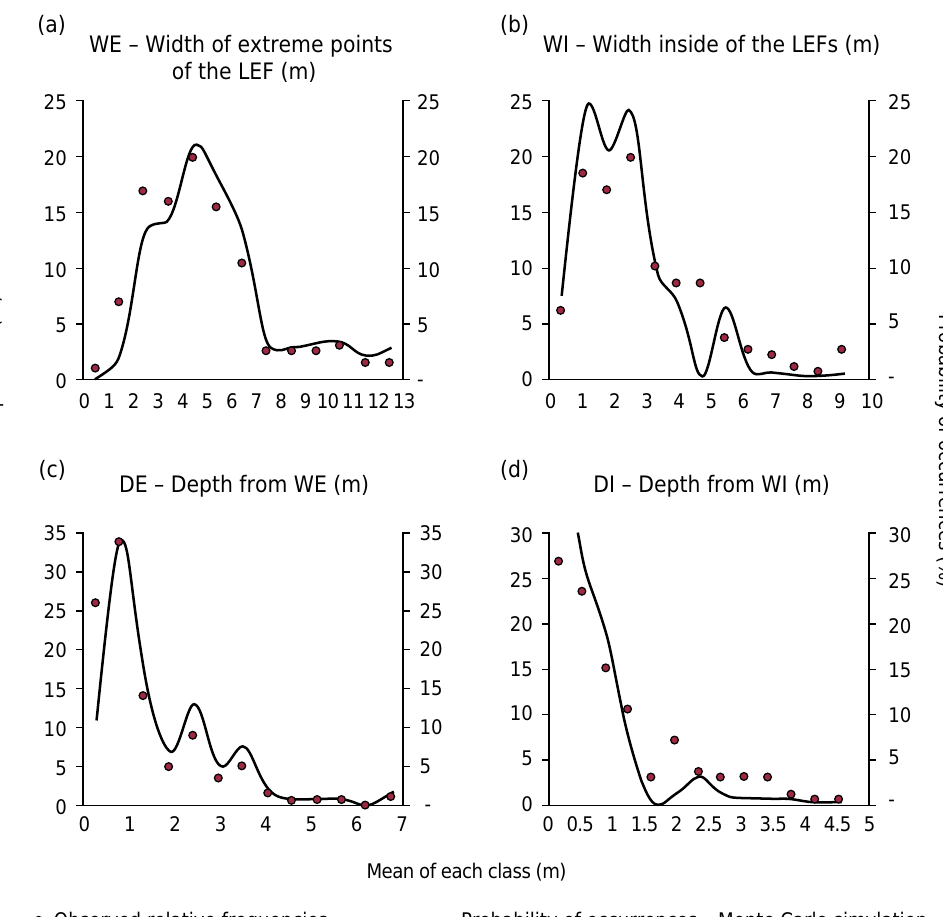
Figure 7. Comparison of observed relative frequencies and simulation results of the probability of occurrences by Monte